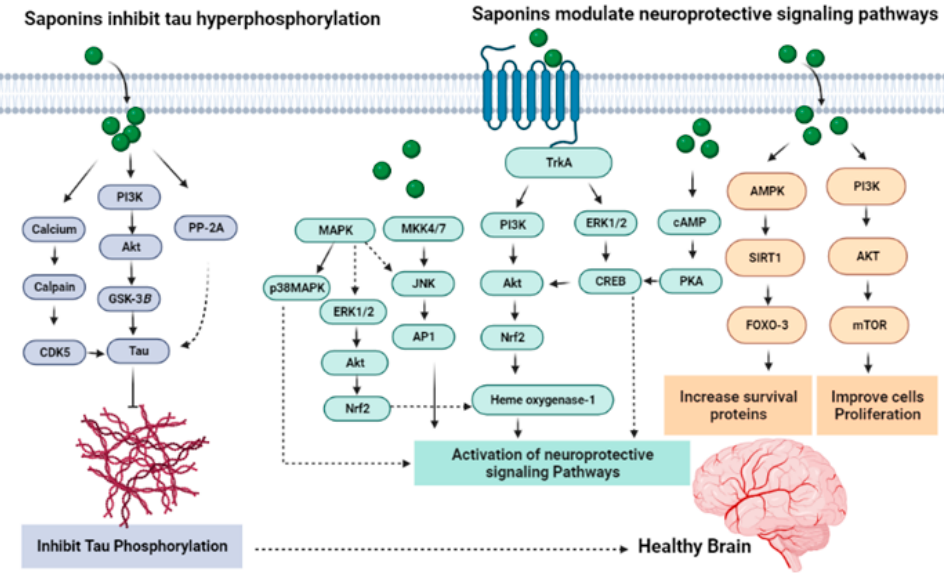
Figure 8. Mechanisms underlying the anti-tau process and modulation of neuroprotective signaling